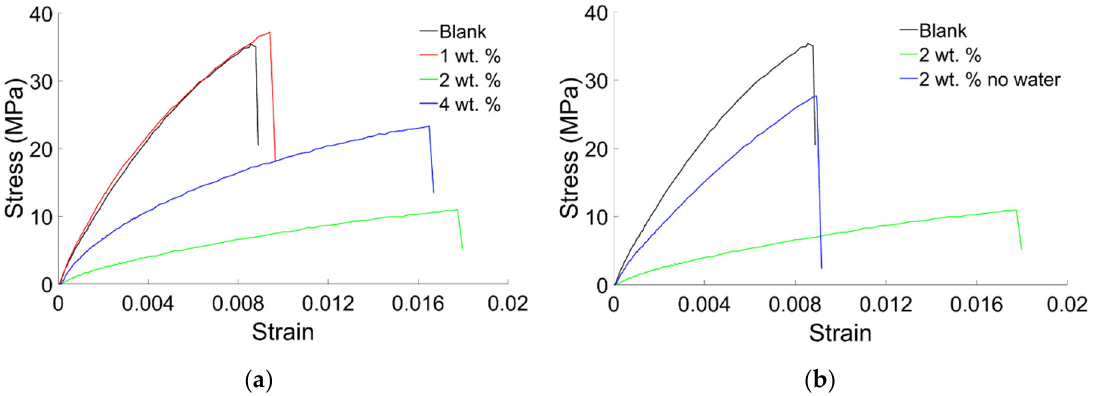
Figure 8. ( a ) Representative curves of three-point bending tests performed on samples obtained using water. ( b ) Comparison between representative curves of three-point bending tests carried on samples obtained with and without water.